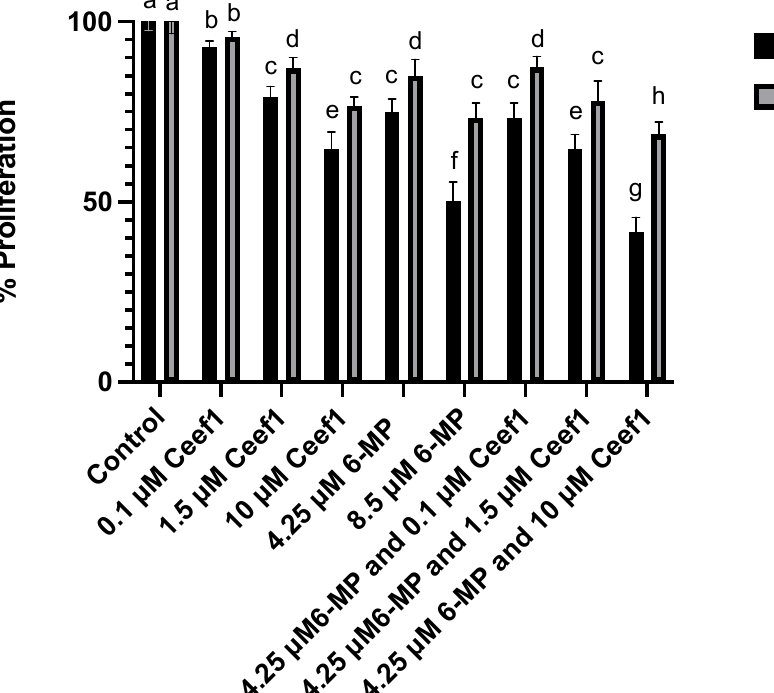
Figure 3. Different combinations and individual treatments of 6-MP and Ceef1 in both, Jurkat cells and CRL-1991 cells, to test their effect on cell proliferation. Mean +/ − SE are shown in each column. Significant differences between groups are represented as different letters ( p -value ≤ 0.05), according to two-way ANOVA and Bonferroni´s multiple comparison test.